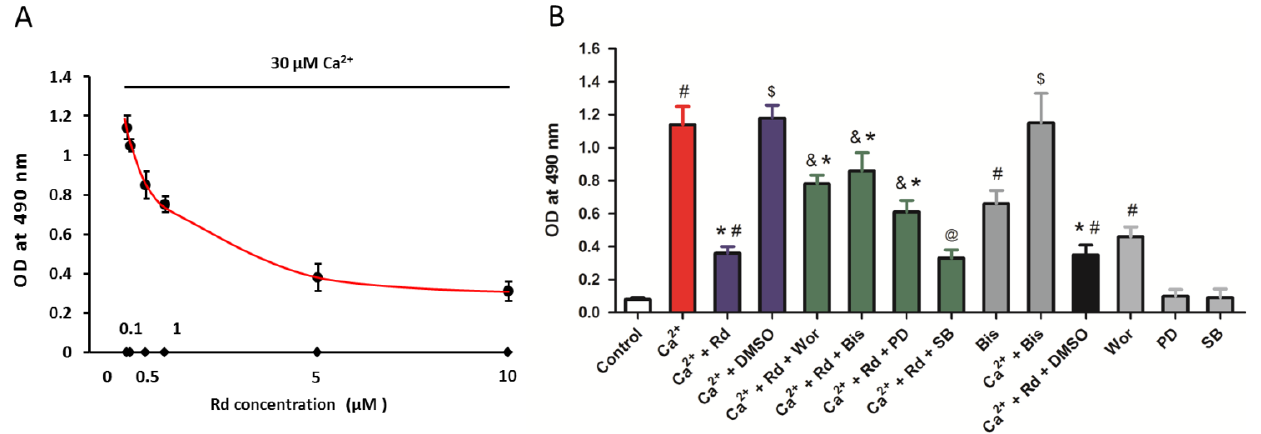
Figure 5. Effects of Rd and protein kinase inhibitors on cytochrome c release after Ca 2+ treatment in isolated spinal cord mitochondria. ( A ) Isolated spinal cord mitochondria (0.5 mg protein/mL supported by succinate) were pretreated with Rd at different concentrations (0.1, 0.5, 1, 5, or 10 μM) for 10 min before the incubation with 30 μM Ca 2+ . The cytochrome c release induced by Ca 2+ was measured; ( B ) Isolated spinal cord mitochondria (0.5 mg protein/mL supported by succinate) were pretreated with 1 μM wortmannin (Wor, PI K inhibitor), 50 nM bisindolylmaleimide (Bis, PKC inhibitor), 3 10 μM PD98059 (PD, ERK inhibitor), or 10 μM SB202190 (SB, p38 inhibitor) in the presence or absence of 10 μM Rd for 10 min before the incubation with 30 μM Ca 2+ . The cytochrome c release induced by Ca 2+ was measured. The data were represented as means ± SD from five experiments. # p < 0.05 vs. control. * p < 0.05 vs. Ca 2+ . & p < 0.05 vs. Ca 2+ + Rd. @ not statistically significant vs. Ca 2+ + Rd. $ not statistically significant vs. Ca 2+